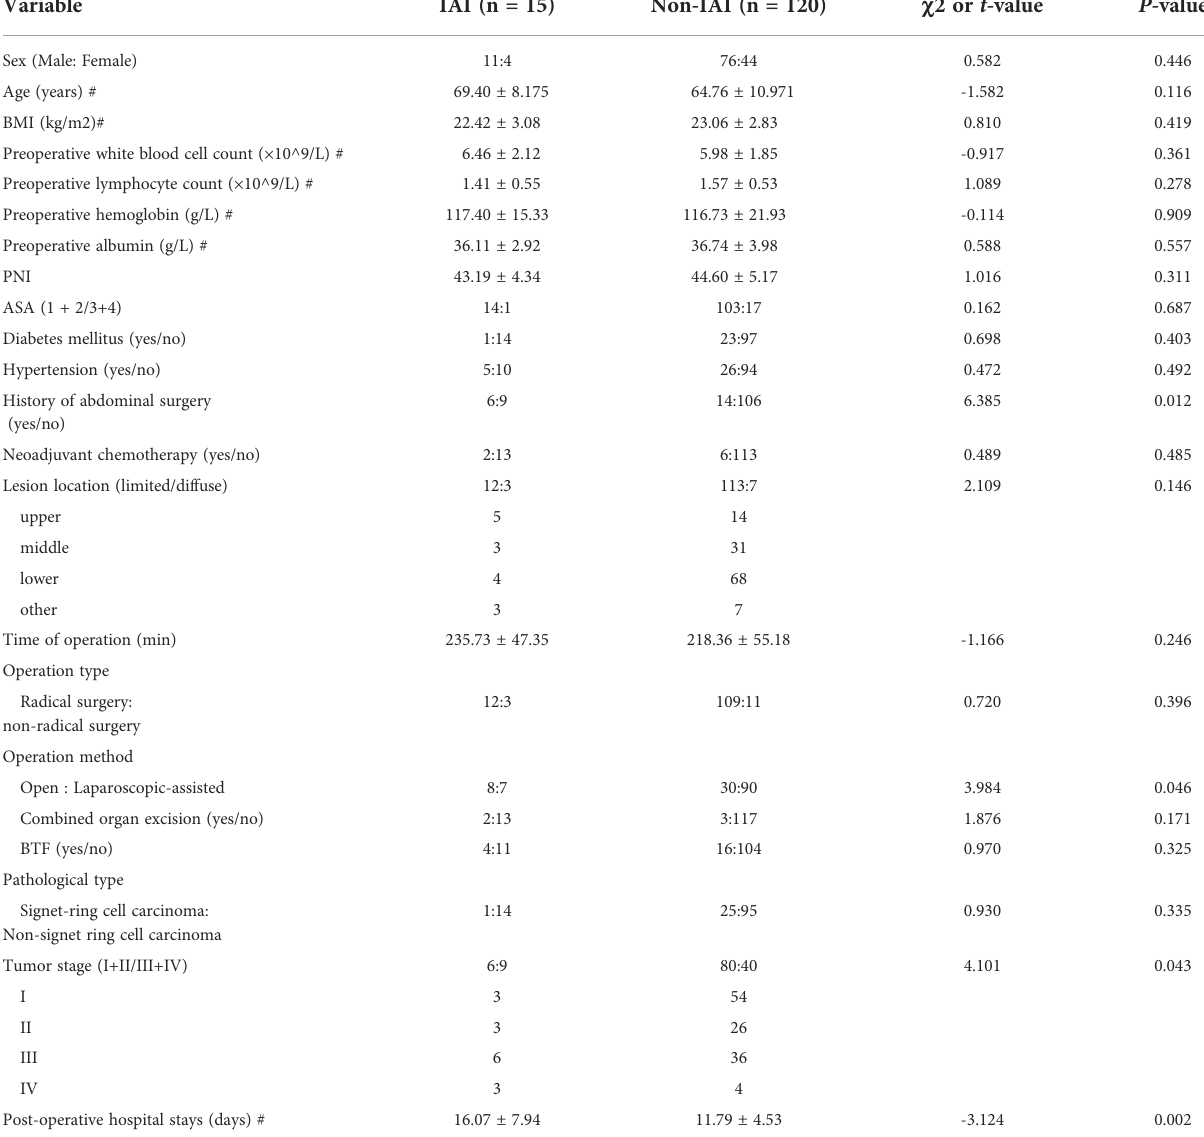
TABLE 2 Clinicopathological characteristics of the patients in internal validation data (n = 135). IAI (n =